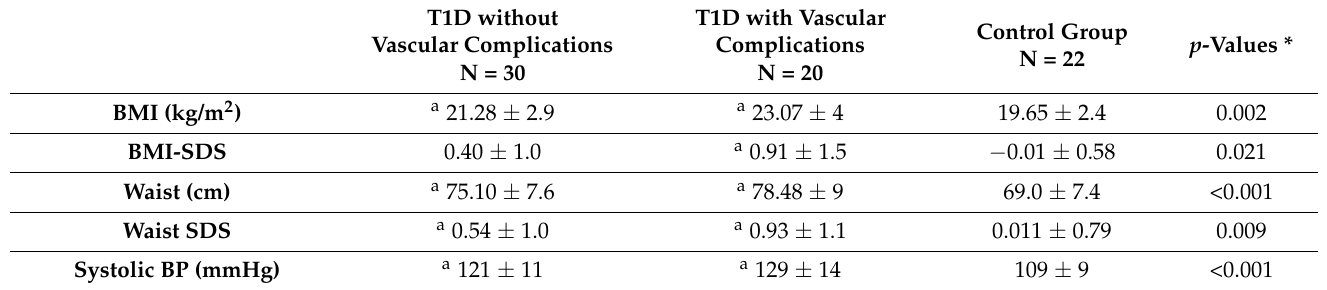
Table 2. Clinical characteristics, lipids, metabolic control, “new biomarkers” of cardiovascular disease between study groups. The results are presented as mean ± SD or median (interquartile range). T1D